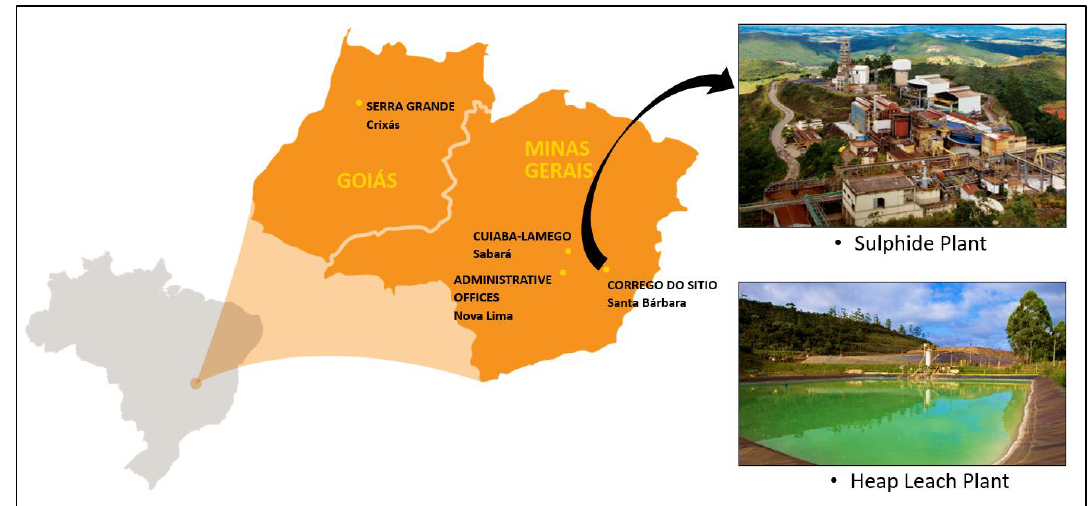
Figure 1. AngloGold Ashanti CDS—Geographical location of the plant in Brazil (illustrative without scale).